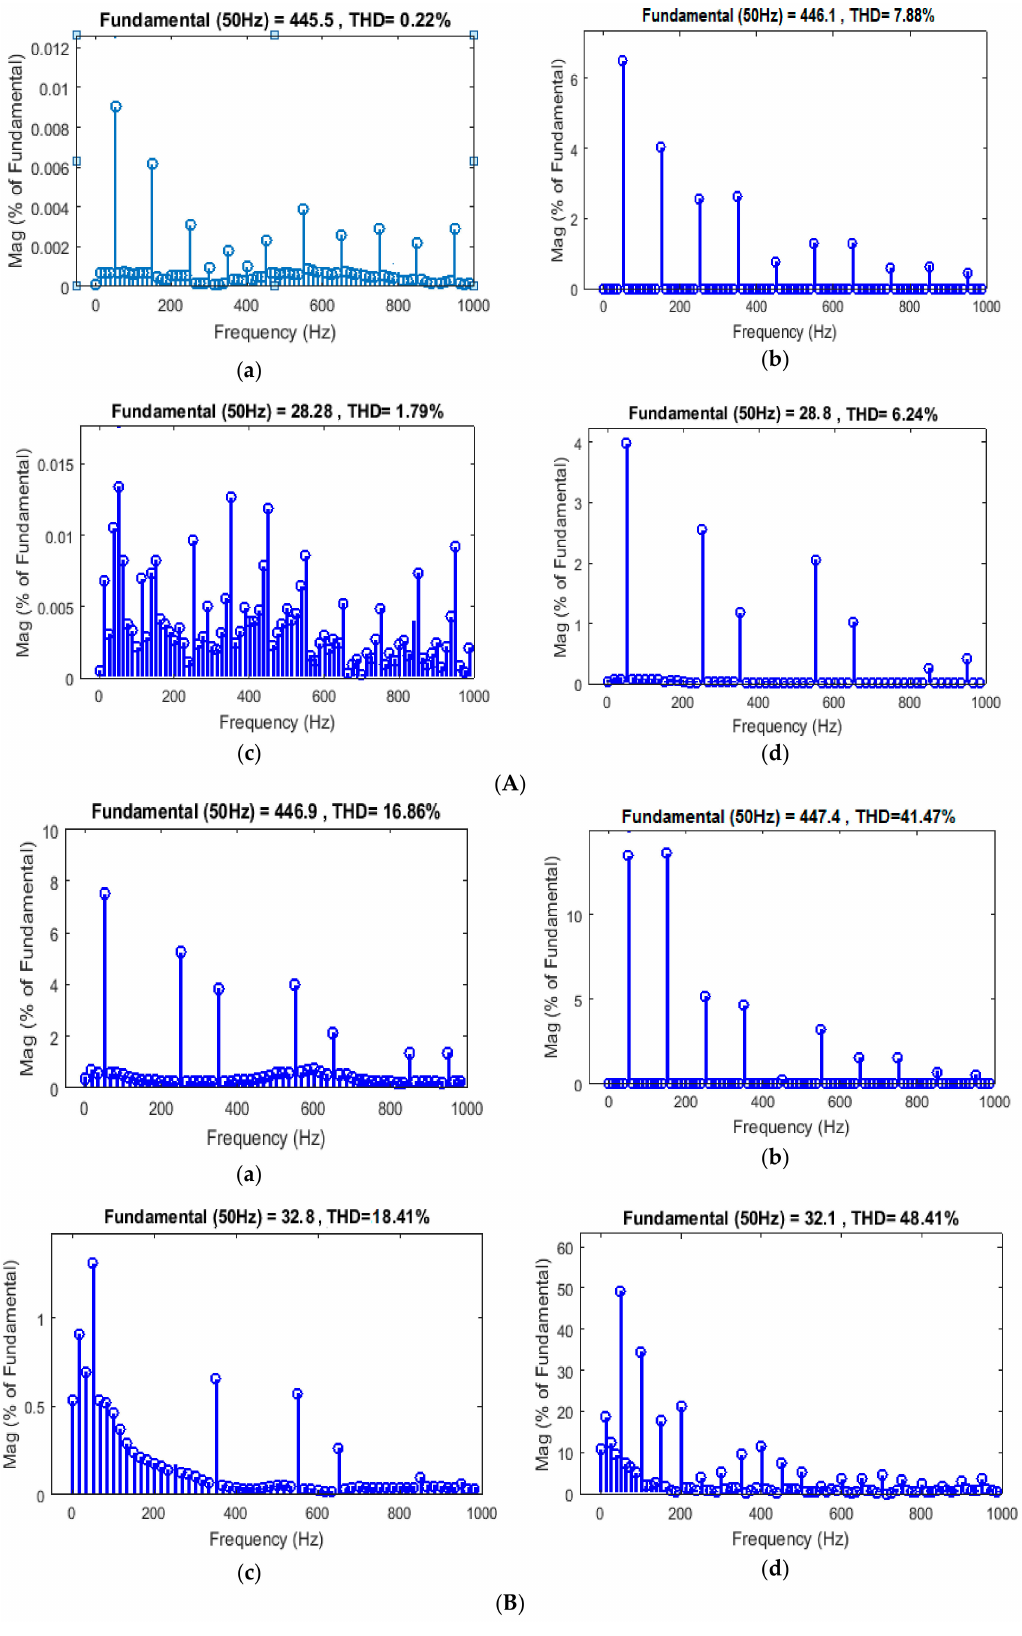
Figure 15. THD analysis for 3-phase 4-leg NPC inverter ( A ) with balanced load; ( B ) with unbalanced load, where ( a ) output voltage with effectual 3D-SVM; ( b ) output voltage with 2D-SVM; ( c ) output current with effectual 3D-SVM; and ( d ) output current with